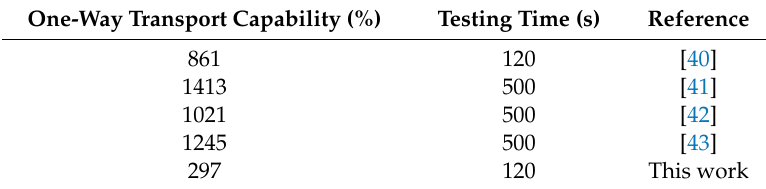
Table 1. Investigation of the one-way transport capability of previously reported works and this